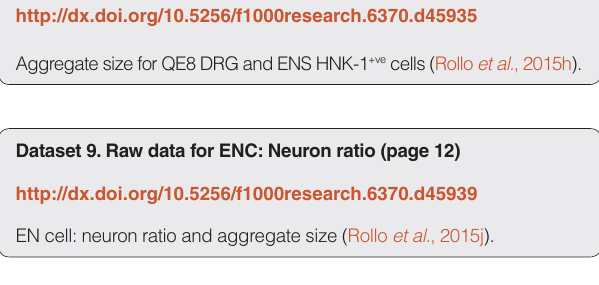
Dataset 8. Raw data for Figure 9A